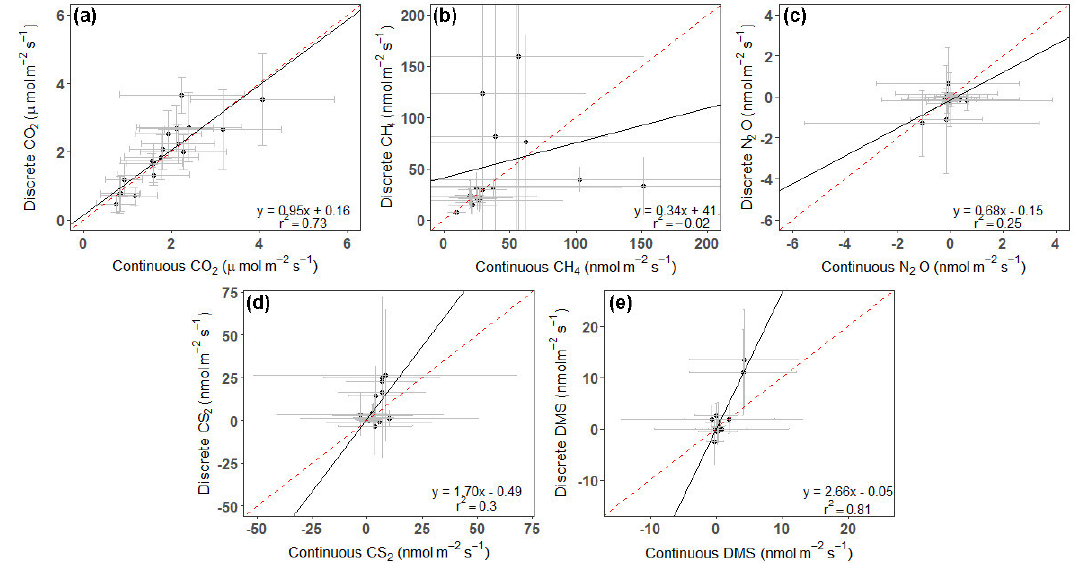
Figure 5. Plots comparing the daily average of continuous (over ∼ 72h) to discrete (1 h before and 1 h after daytime low tide) measurements for (a) CO 2 , (b) CH 4 , (c) N 2 O, (d) CS 2 , and (e) DMS. Error bars represent the SD and have been cut off in panel (b) to show data better. See Fig. S3 for full error bars for panel (b) . Dashed red line is the 1 : 1 line, while the solid black line is the trend